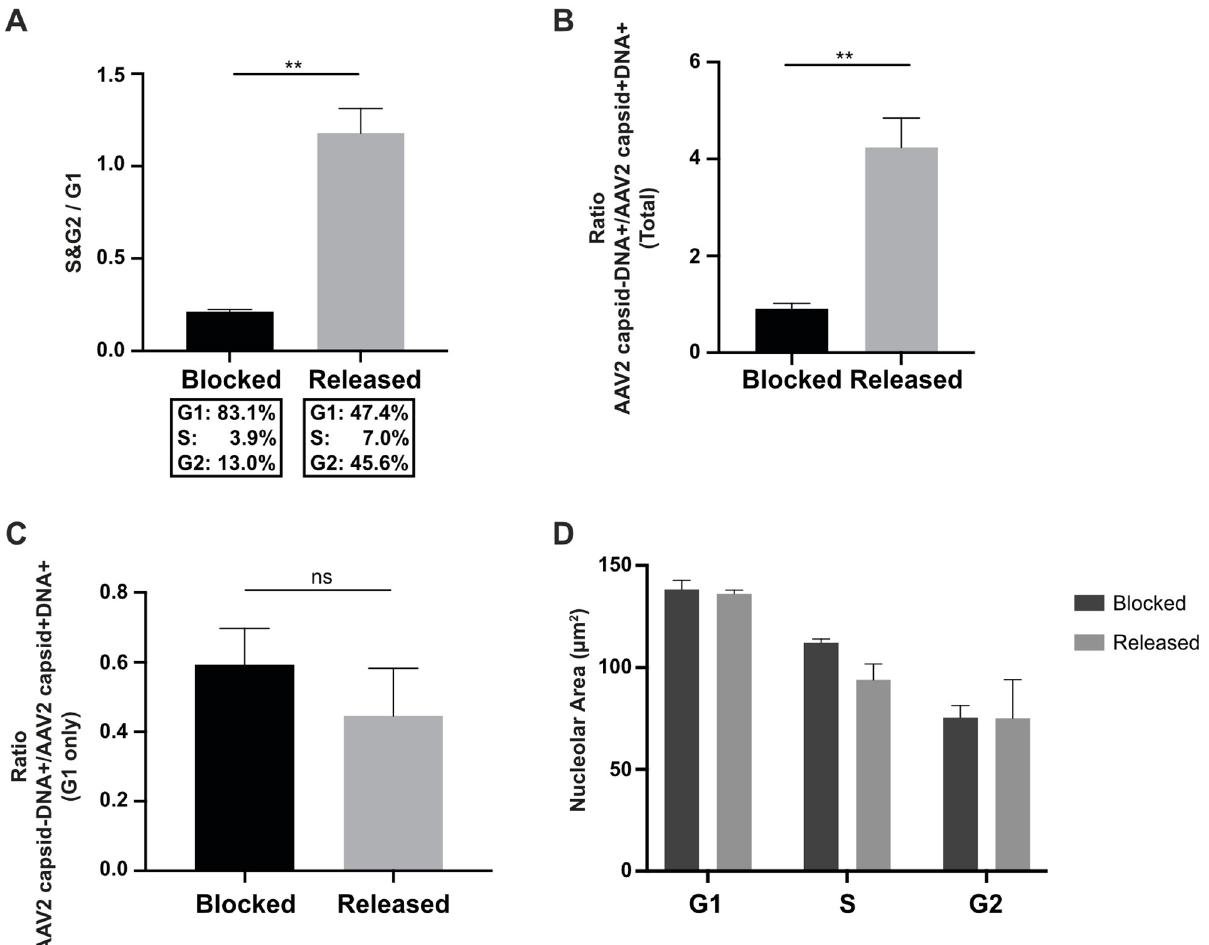
Fig 8. G1 cell cycle arrest obstructs complete uncoating in nucleoli. NHF cells were arrested in G1 cell cycle phase by a double thymidine block before and during infection with wtAAV2 (MOI 20‘000). As control, the cells were released 8 h prior to infection by washing out the thymidine. At 24 hpi, the cells were fixed and processed for multicolor IF analysis combined with FISH, CLSM and image-based analysis of (A) the cell cycle profile after continuous thymidine block or release, respectively. (B) Quantification of the total uncoating rate in nucleoli. (C) Image-based quantification of the uncoating rate in nucleoli in G1 cell cycle phase. (D) Image-based quantification of the nucleolar area after continuous thymidine block or release, respectively. p-values were calculated using an unpaired Student‘s t-test ( � —p � 0.05, �� —p � 0.01, ��� —p � 0.001, ���� —p � 0.0001).